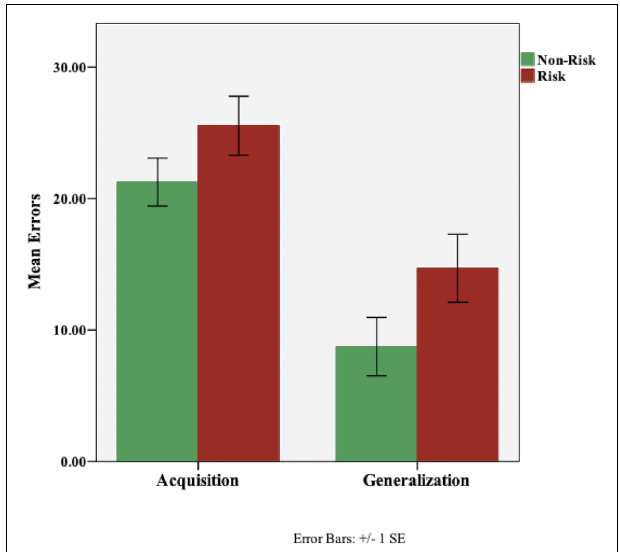
FIGURE 2 | Performance (total errors) on the concurrent discrimination and generalization task based on ABCA7 genotype: Non-Risk (TT) vs. Risk (GG). There were no group differences based on ABCA7 genotype on initial learning (acquisition; p = 0.159) or generalization (p = 0.287). Although, the risk group made more generalization errors, the effect of group was not significant.